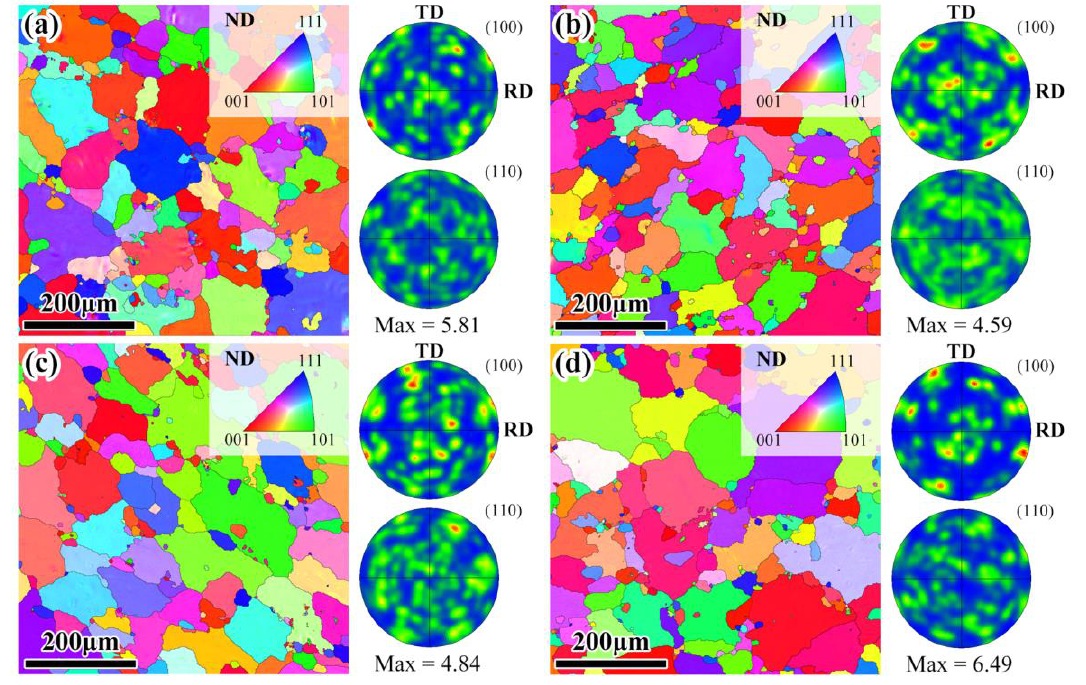
Figure 6. Inverse pole figure and pole figure of the Al layers in composite sheets after annealing: Mg/Al sheet after annealing at ( a ) 400 ◦ C for 3 h, and ( b ) 400 ◦ C for 10 h, Mg/Al-Ti sheet after annealing at ( c ) 400 ◦ C for 3 h, and ( d ) 400 ◦ C for 10 h. RD, TD, and ND refer to the rolling direction, transverse direction, and normal direction, respectively.